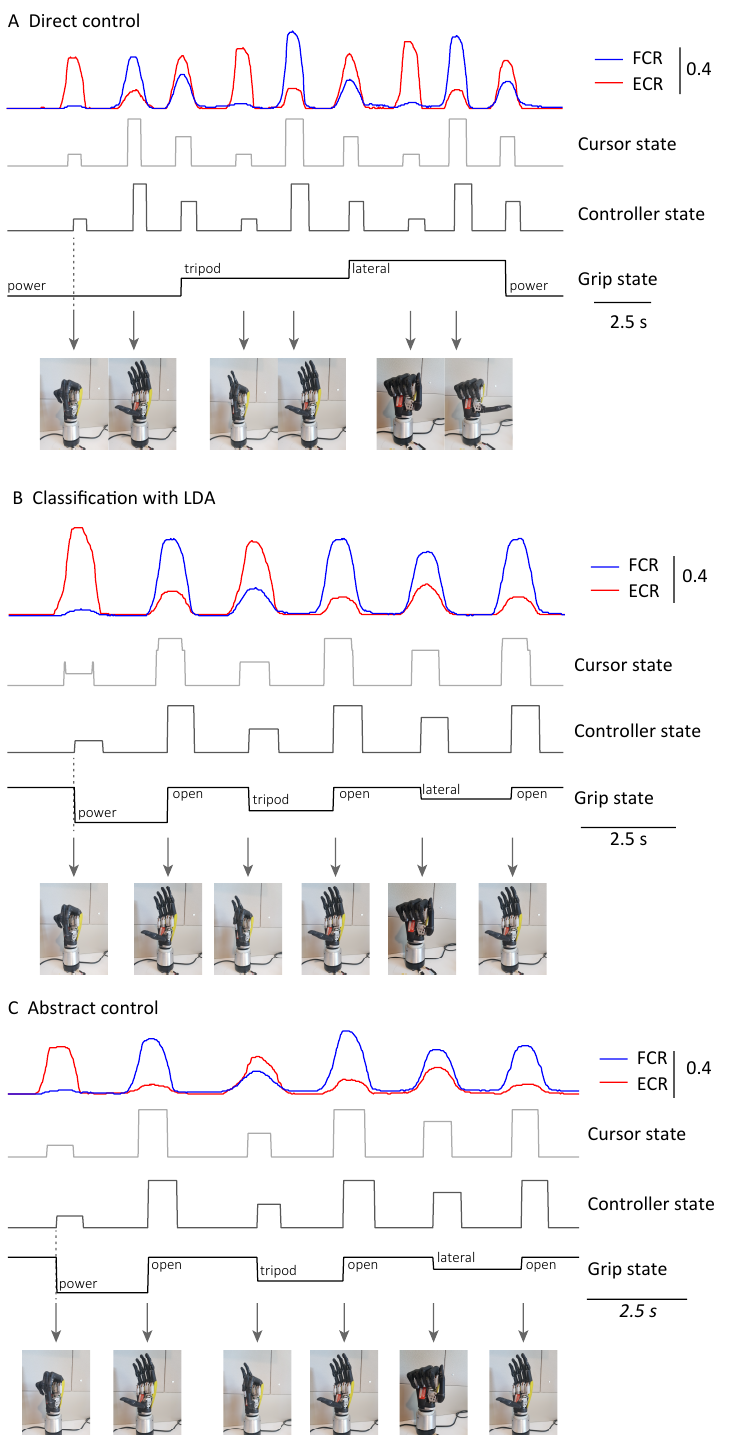
Figure 4. Control signals for the ( A ) direct controller, ( B ) linear discriminant analysis (LDA) classifier, and ( C ) abstract